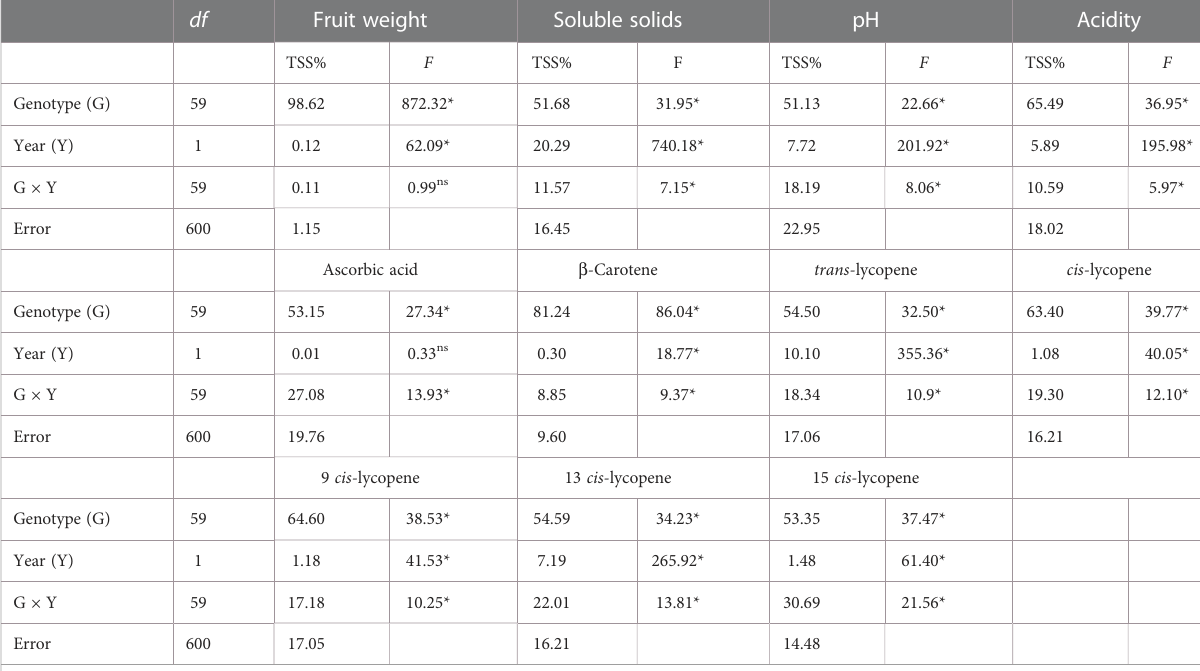
TABLE 3 F values and signi fi cant levels for genotype (G), season (Y), and G × Y effects for the 10 traits on 60 tomato heirloom genotypes over 2 years.